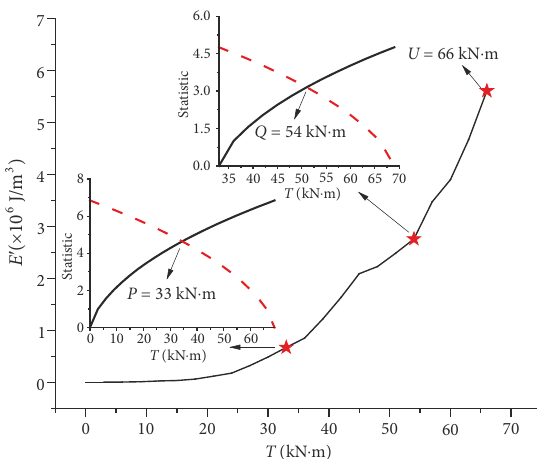
Figure 4. E’ - T and M-K statistic curves of RC